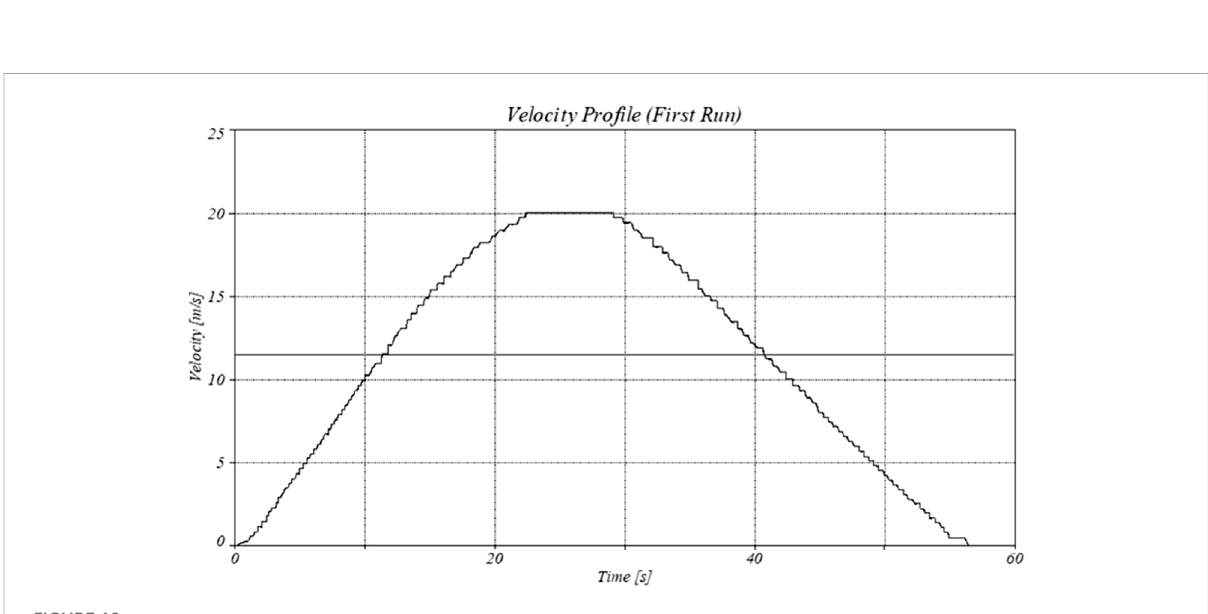
FIGURE 10 Velocity pro fi le for the fi rst